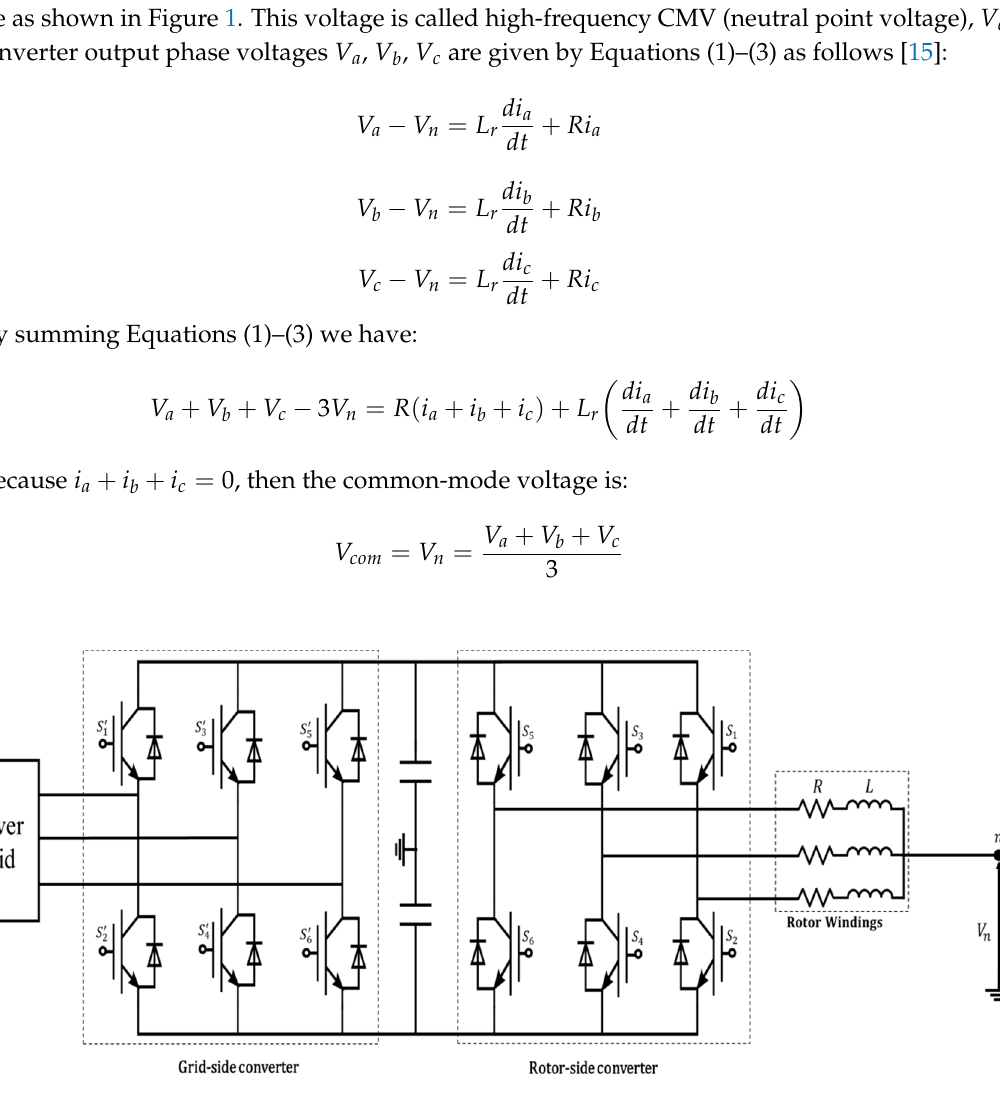
Figure 2. Physical construction of the doubly-fed induction generator showing different stray capacitances. Figure 3. Proposed active common-mode voltage canceler connected between the rotor winding and AC–DC converter of DFIG.